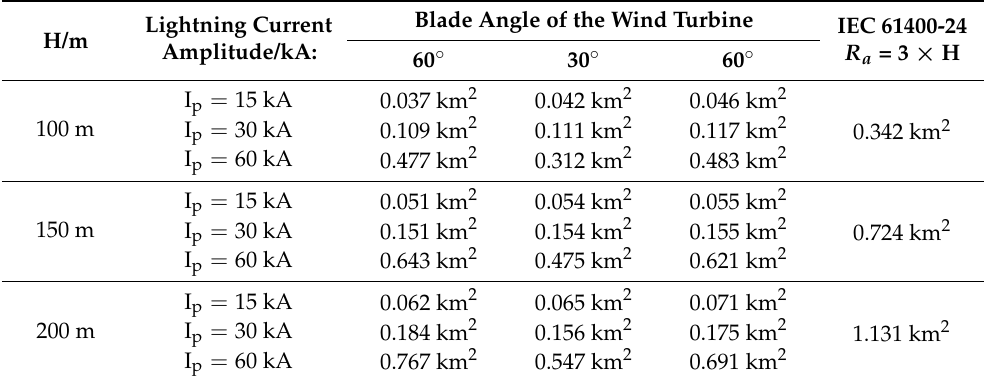
Table 3. The equivalent collection area predicted by the method in this